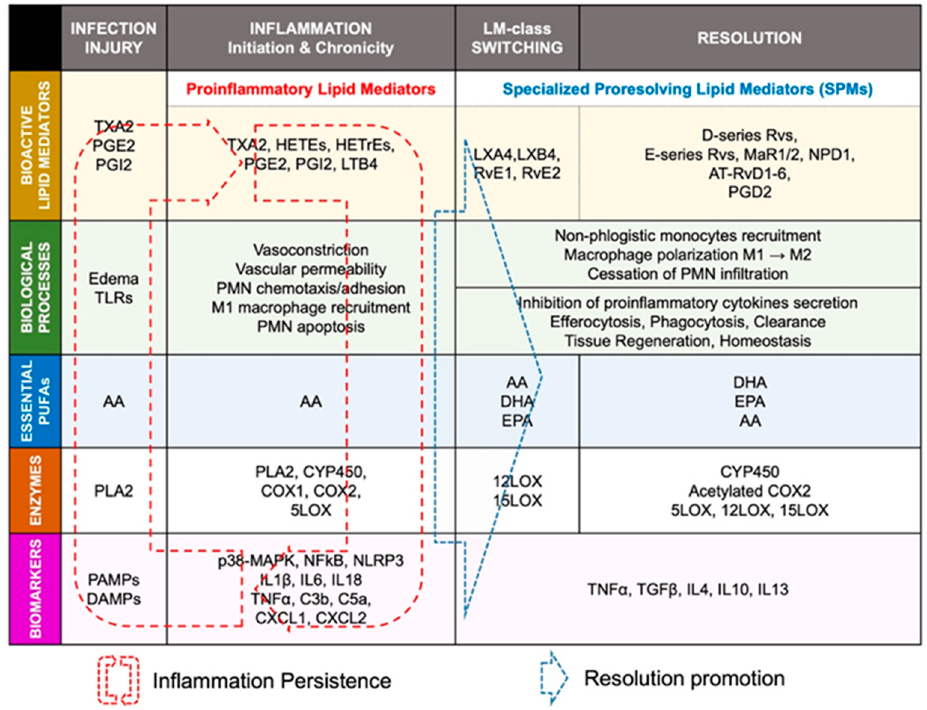
Figure 4. Categorization of inflammation- and resolution-promoting agents. In response to pathogens or injury stimuli (PAMPs, DAMPs), phospholipase A2 (PLA2)-induced biosynthesis of arachidonic acid (AA) leads to the production of proinflammatory lipid mediators including thromboxanes, leukotrienes, and prostaglandins. Such events mark the initiation phase of acute inflammation characterized by PMN chemotaxis, pro-inflammatory-[M1]-macrophages recruitment, and enhanced proinflammatory signals (NLRP3 inflammasome, NF- κ B, IL-1 β , CXCL1/2). Phagocytic M1-macrophages release 12/15 LOX, which promotes the activation of lipid-mediators (LM) class switching, where AA, docosahexaenoic acid (DHA), and eicosapentaenoic acid (EPA) interact with 12LOX and 15LOX enzymes to be metabolized into specialized pro-resolving mediators (SPMs) including PGD2 from AA, D-series resolvins from DHA, or E-series resolvins from EPA. SPMs promote anti-inflammatory (M2)-macrophage recruitment, inhibition of proinflammatory cytokines’ secretion, termination of inflammation, and regeneration of optimal functions. When the resolution mechanisms fail to occur, inflammation is perpetuated. Inflammatory mediators are overexpressed, leading to persistence of cellular damages, necrosis, fibrosis, loss of function and cardiac vulnerability to arrhythmias, and heart failure. Strategies promoting the augmentation of pro-resolution mechanisms can potentially limit, or eventually reverse, some chronic-inflammation-induced cardiac disorders.